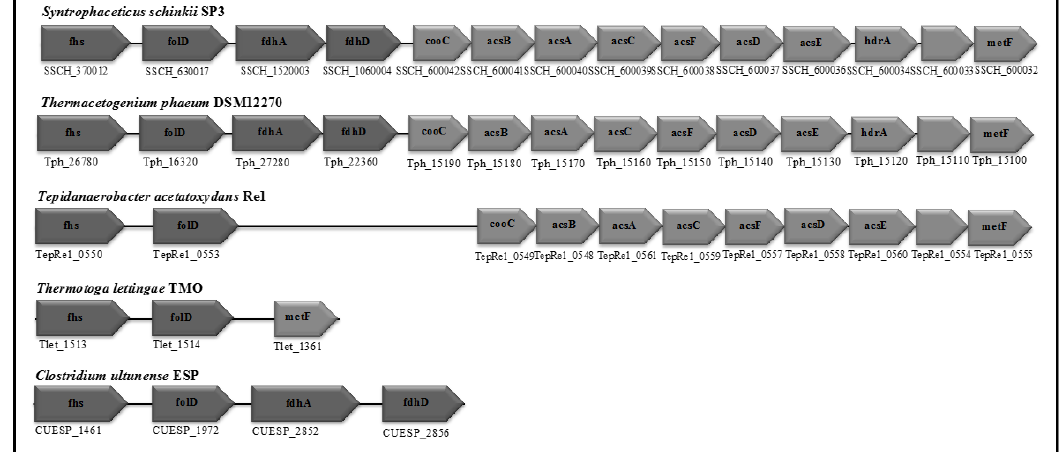
Figure 5. Organisation of the WL pathway genes in the SAOB S. schinkii , Th. phaeum , T. acetatoxydans , C. ultunense strain Esp (also valid for strain BS T ) and P. lettingae . acsA,B,C,D,F, Carbon monoxide dehydrogenase/Acetyl-CoA synthetase subunits; acsE, Methyltransferase; hdr, heterodisulphide reductase; metF, methylene tetrahydrofolate reductase; folD, bifunctional methenyl tetrahydrofolate cyclohydrolase/methylene tetrahydrofolate dehydrogenase; fhs, formyl tetrahydrofolate reductase; cooC, accessory protein; fdhA/fdhD, formate dehydrogenase. Light grey: Genes are organized in a putative operon. Dark grey: Genes are scattered in the genome.